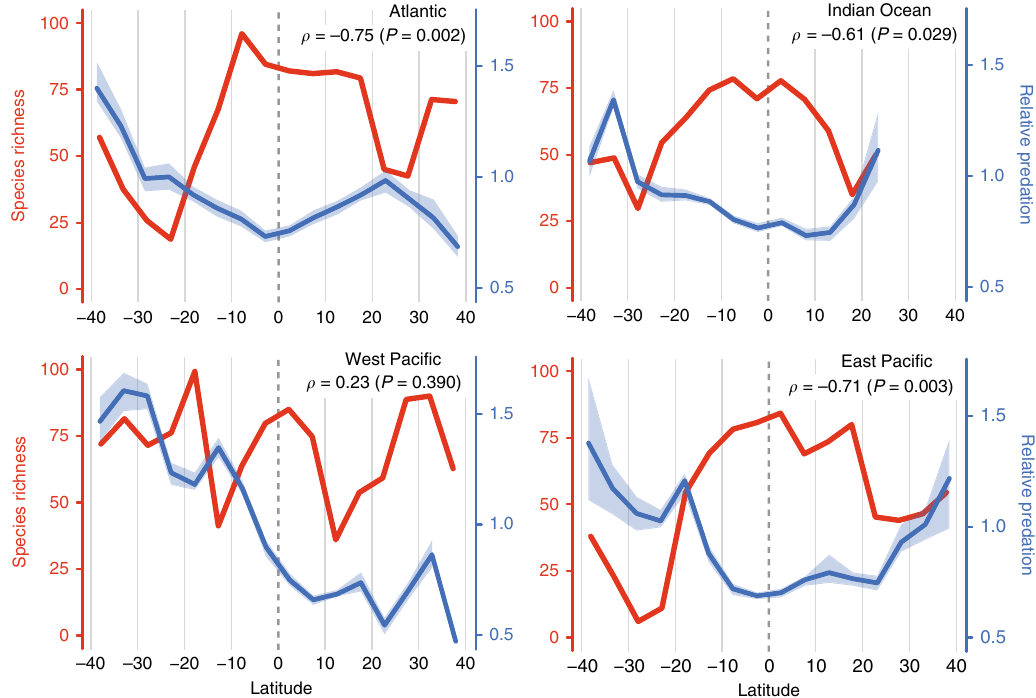
Fig. 4 Association between latitudinal variation in fi sh species richness and relative predation. Median number of pelagic fi sh species was estimated from global species range maps 46 (red lines), and compared to median relative predation by predatory fi sh across latitude in bands of fi ve degrees (blue lines with non-parametric 95% con fi dence intervals). To account for the effect of time in overall relative predation (see Supplementary Fig. 1), annual relative predation estimates were standardized by the mean relative predation of the respective year prior to calculating latitudinal medians. Spearman ’ s rho and the statistical signi fi cance (non-parametric P- values) of the association between median species richness and median relative predation across latitude are given in the top right of each plot. Because non-pelagic fi sh and non- fi sh predators are the dominant oceanic predators at absolute latitudes >40° 39,40 , this analysis was restricted to latitudes between 40°S and 40°N. Source data are provided in Supplementary Data